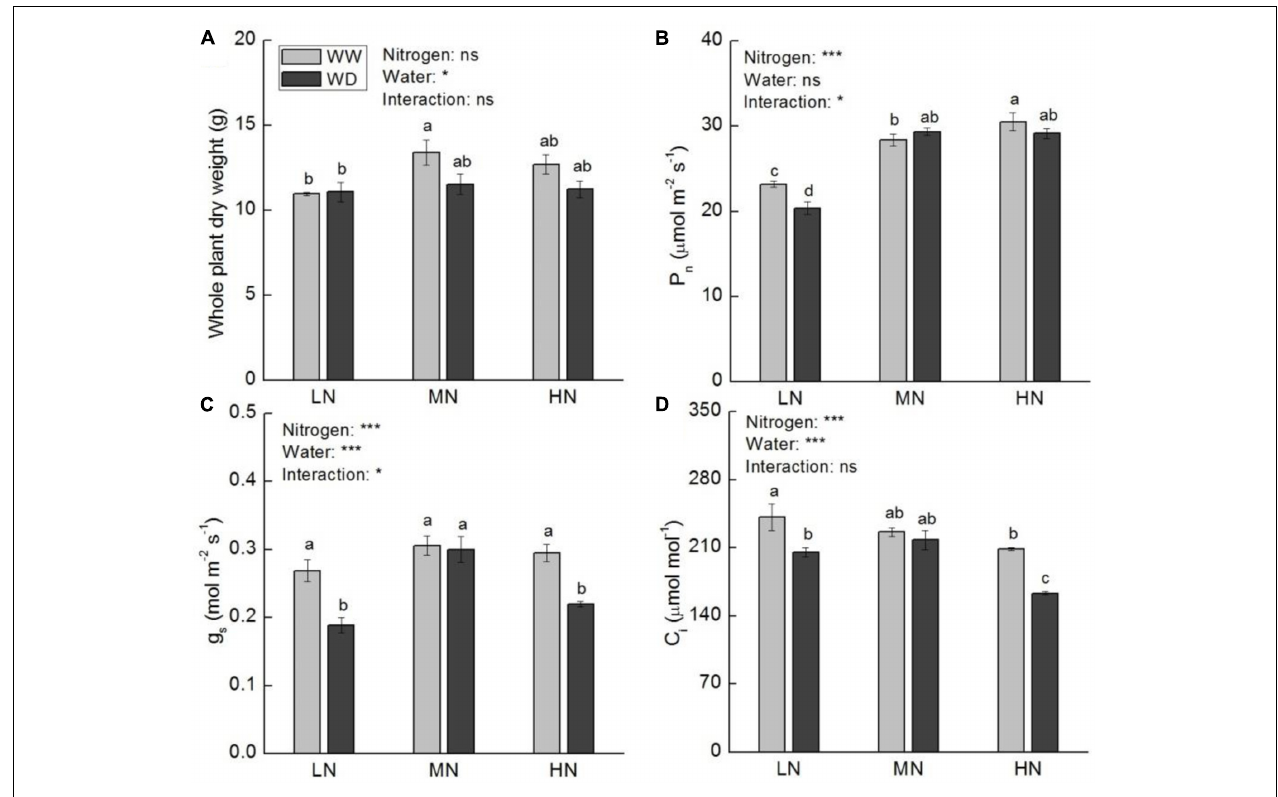
FIGURE 2 | Comparison in whole plant dry weight (A) , net photosynthetic rate ( P n , B ), stomatal conductance ( g s , C ), and intercellular CO 2 concentration ( C i , D ) in rice plants grown udner different nitrogen and water conditions. Data refers to mean ± SE ( n = 4). P -values of the two-way ANOVAs of nitrogen, water, and their interaction are indicated: ns, not significant; ∗ P < 0.05; ∗∗ P < 0.01; ∗∗∗ P < 0.001. Bars with the same letter are not significantly different by LSD test. WD, water deficit; WW,